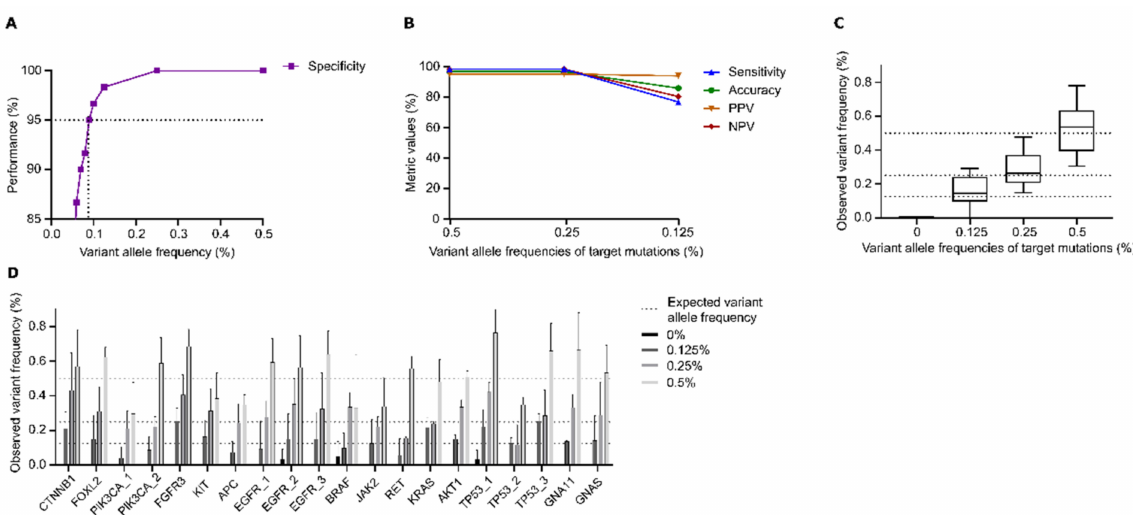
Figure 2. DEEPGEN TM assay performance using SeraseqTM ctDNA Mutation Mix v2 reference standard with validated minor allele frequencies of 0%, 0.125%, 0.25% or 0.5% VAF as input. ( A ) The specificity of the DEEPGEN TM assay is shown for a range of 0.01–0.5% VAF as threshold. The dotted line indicates the targeted quality threshold of 95%. ( B ) Sensitivity, accuracy, PPV and NPV for the verified VAFs of 0.125%, 0.25% and 0.5%. ( C ) Box plot of observed frequencies for each tested validated VAF. Whiskers represent the range of the 90 percent confidence interval. ( D ) Detected variant frequencies per validated target variant versus expected reference variant frequency. Data represent mean ± SD ( n =